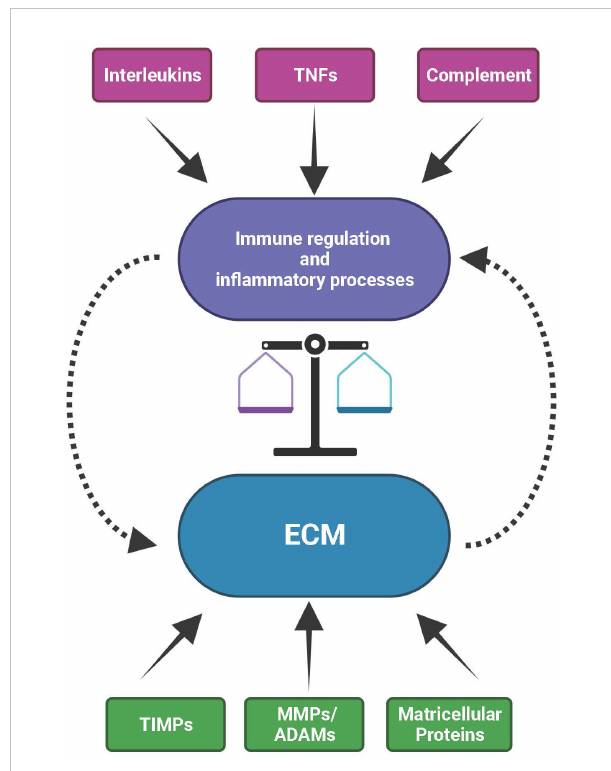
Figure schematics and cartoons were created with